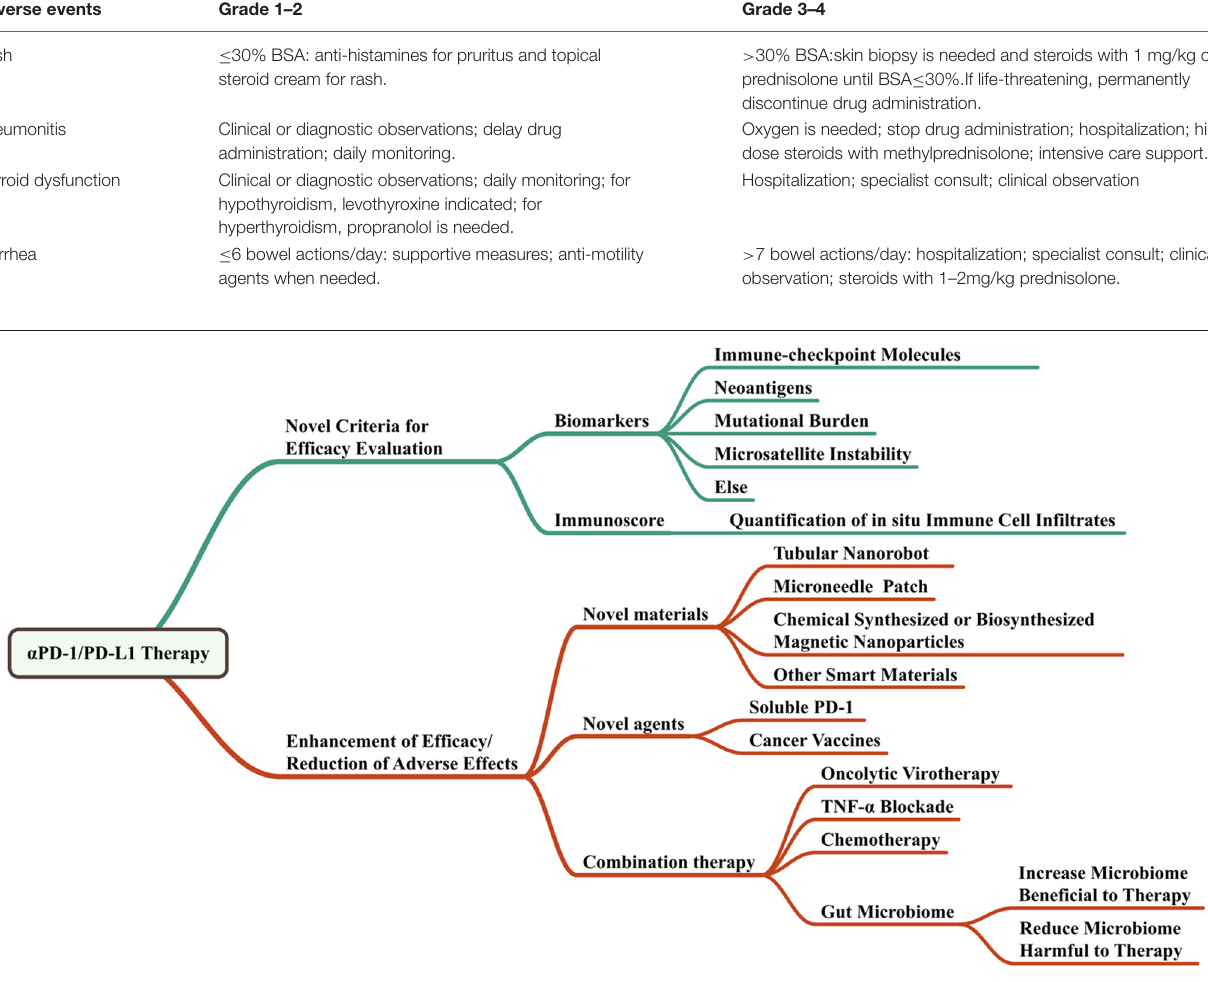
FIGURE 4 | Perspectives of anti-PD-1/PD-L1